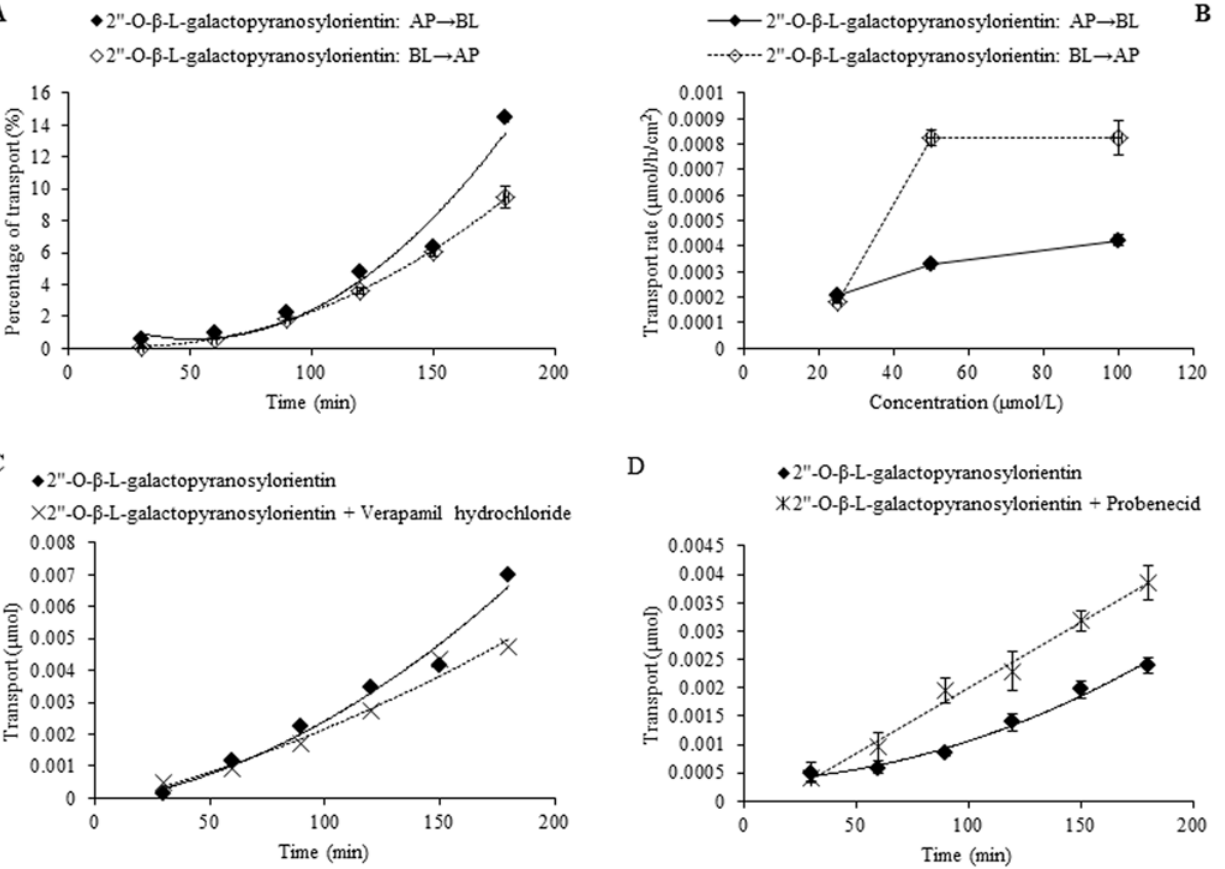
Fig 10. Transport of 2 ” - O - β -L-galactopyranosylorientin across Caco-2 cell monolayer. Notes: (A) The percent transport of 2 ” - O - β -L- galactopyranosylorientin as a function of time at 50 μ mol/L; (B) The transport rate of 2 ” - O - β -L-galactopyranosylorientin as a function of concentration at 90 min; (C) The effect of verapamil hydrochloride on the transport of 2 ” - O - β -L-galactopyranosylorientin as a function of time at 50 μ mol/L; (D) The effect of probenecid on the transport of 2 ” - O - β -L-galactopyranosylorientin as a function of time at 50 μ